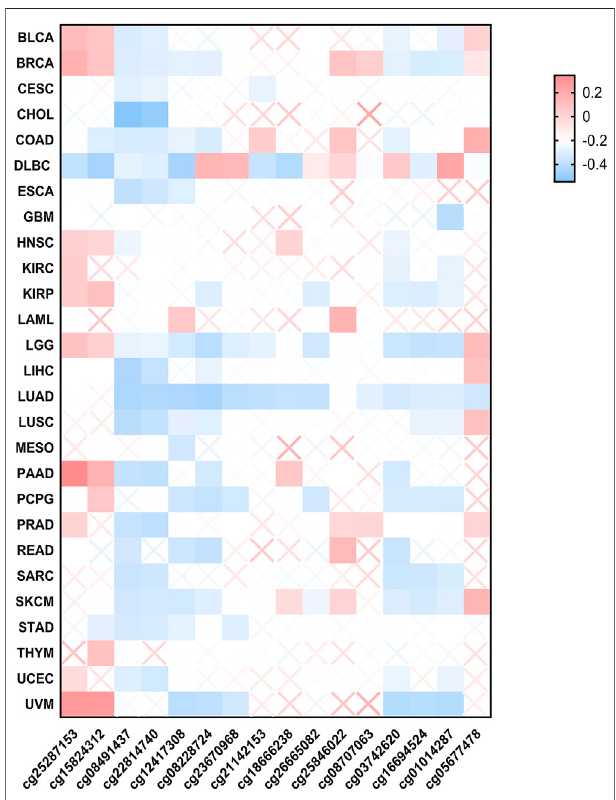
FIGURE 4 | The methylation status of FUBP1 in different cancer types. Multiple probes were used to explore the methylation of FUBP1 via MEXPRESS, and the corresponding heatmap data in different cancers were displayed using GraphPad software.